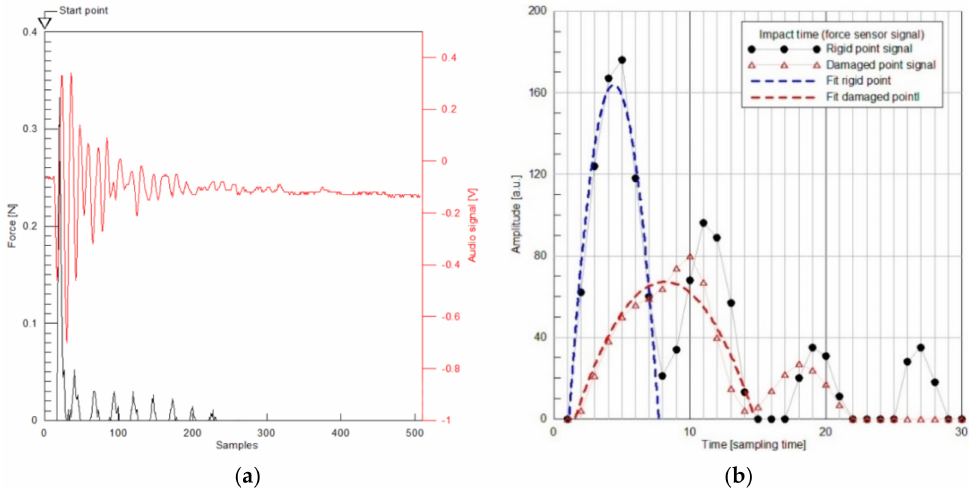
Figure 7. An example of the acquired audio signal and the relative force sensor signal. In ( a ) is showed the window of the samples that will be calculated by the cross-correlation algorithm. In ( b ) the comparison between the contact-time of a rigid area (blue fit) vs. a damaged area (red